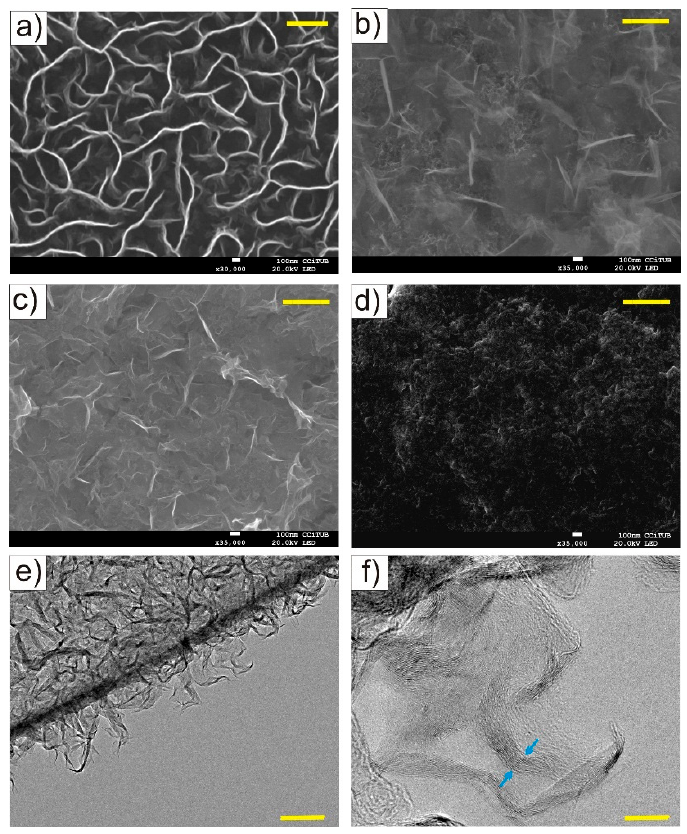
Figure 2. SEM images of GNWs grown on SS, ( a ) MnO 2 /GNWs without thermal treatment, ( b ) MnO 2 /GNWs with annealing at 200 ◦ C ( c ) and 600 ◦ C ( d ). TEM images of as grown GNWs ( e ), ( f ). Arrows indicate thickness of the nano-walls. Scale bars correspond to 500 nm in ( a – d ). 100 nm in ( e ) and 10 nm in ( f ).